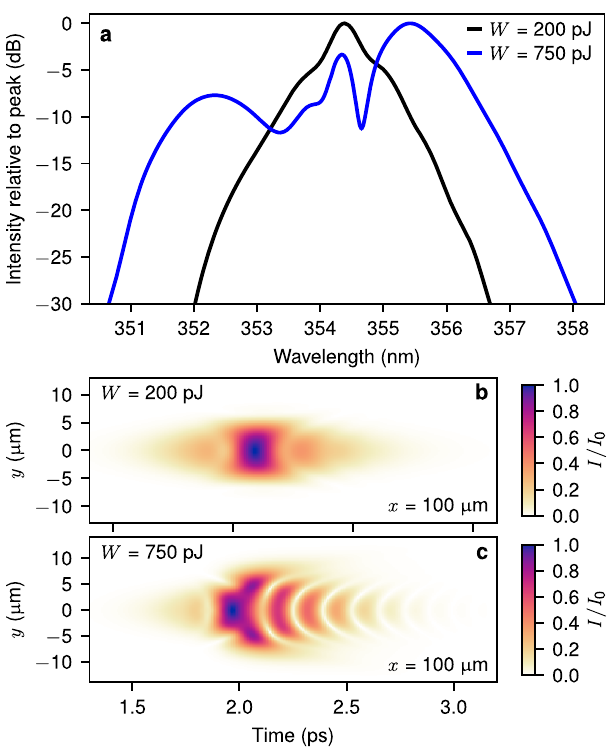
Fig. 4 Simulated nonlinear pulse propagation. a Numerically calculated normalized spectra of the output fi eld corresponding to temperature T = 100 K, detuning Δ = − 92 meV and pulse energies W of 200 pJ (black lines) and 750 pJ (blue). b , c The numerically calculated spatio-temporal distributions of the intensity I of the fi eld relative to the peak I 0 after 100 μ m propagation in the planar waveguide for incident pulse energies 200 pJ ( b ) and 750 pJ ( c ).